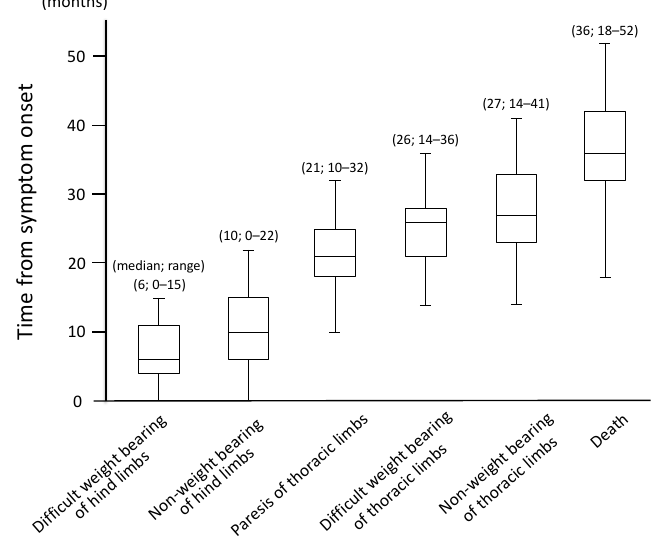
Figure 1. Time course of gait impairment in 40 dogs with degenerative myelopathy. Table 1. Prevalence and time from symptom onset other than gait disorder.